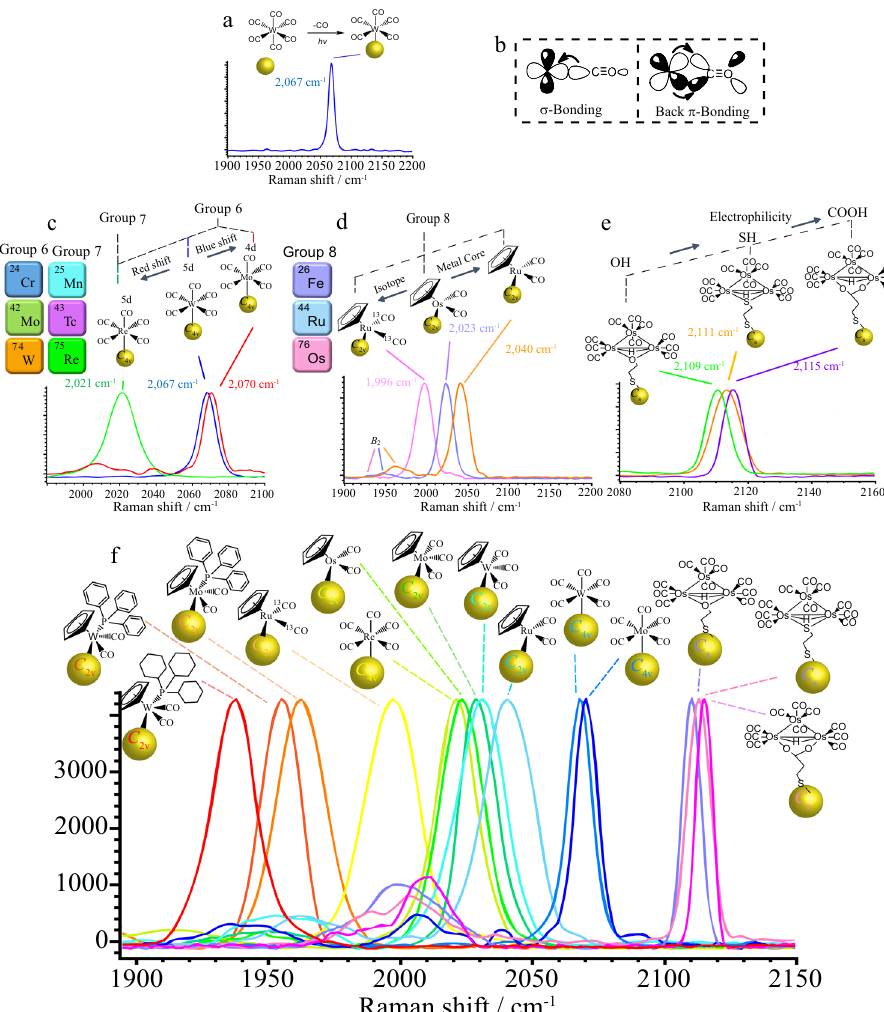
Fig. 2 Multiplexing geometrically encoded SERS nanobarcodes. a Raman spectra of W(CO) 6 on Au nanoparticles. b Schematic illustration of σ and back- π bonding interactions between the d orbitals of the metal and CO ligand. c Tuning of the totally symmetric mode (~2000 cm − 1 region) of C 4v geometry SERS reporters by doping with various groups of transition metals, resulting in different levels of synergistic bonding effects. d Application of Cp as a σ ligand and isotope effect to tune the totally symmetric mode (~1900 cm − 1 region) of C 2v geometry SERS reporters. e Linkage effect on fi ne-tuning of the totally symmetric mode (~2100cm − 1 region) of C s geometry SERS reporters. f Multiplexed CO nanotags. SERS peaks of CO nanotags in the optical interference-free window. Source data are provided as a Source Data fi